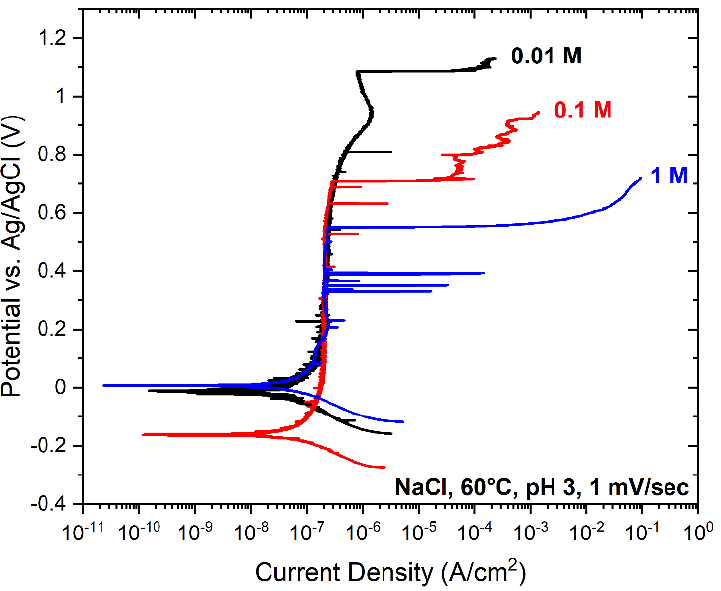
Figure 2. Potentiodynamic polarisation (1 mV/s) in NaCl solutions at pH 3 and 60 °C.